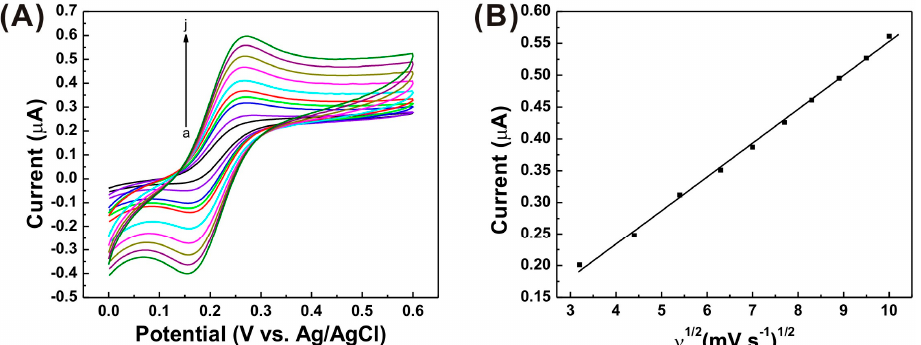
Figure 4. ( A ) Cyclic voltammograms of AuNP/carbon IDEs in 10 mM [Fe(CN) 6 ] 4 − with 0.1 M KCl at various scan rates from curve a to j corresponding to 10, 20, 30, 40, 50, 60, 70, 80, 90, 100 mV/s. ( B ) The relationship between the peak currents and the square roots of the scan rates.